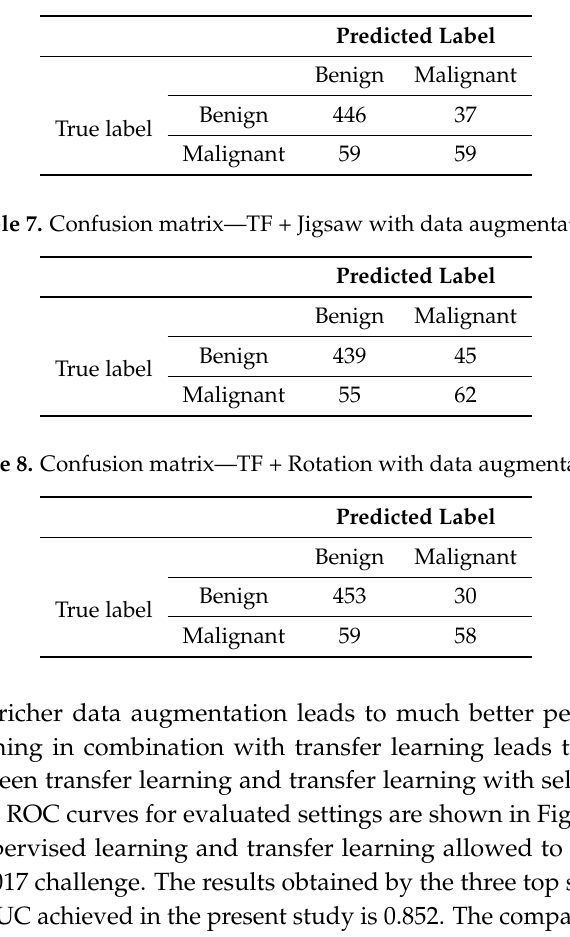
Table 6. Confusion matrix—TF (transfer learning) with data augmentation.